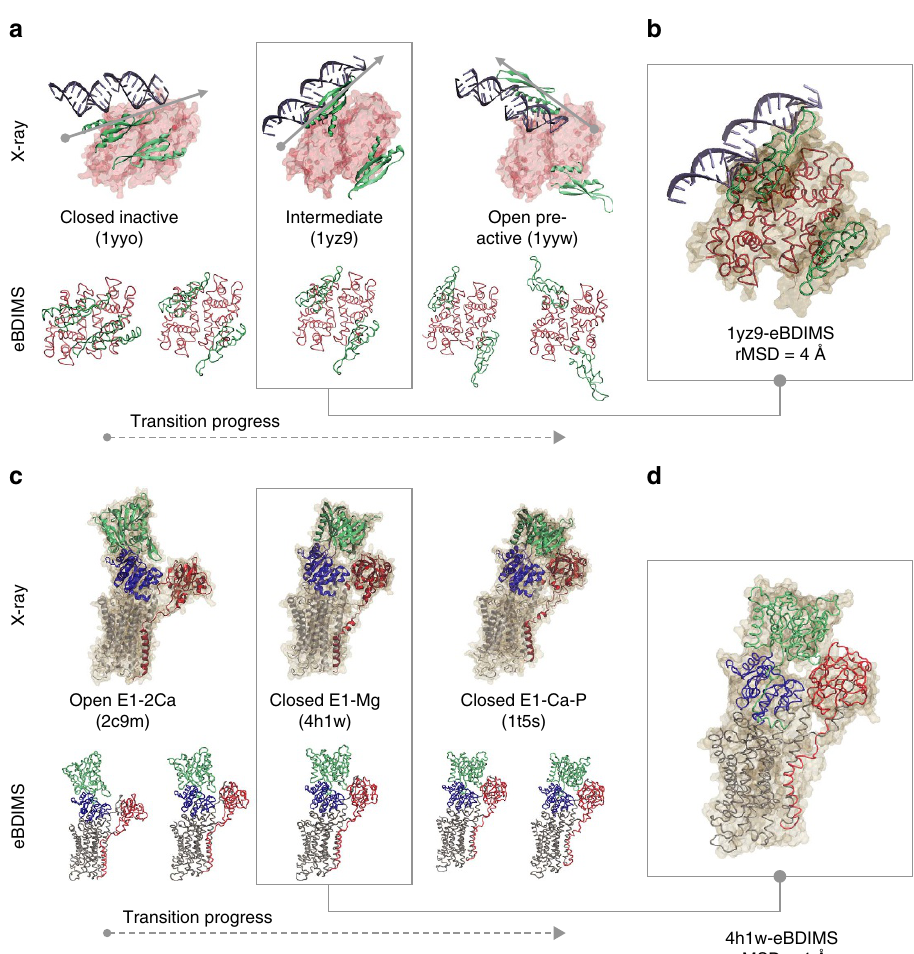
Figure 6 | Comparison between the crystallographic and the eBDIMS pathways for RNaseIII and SERCA. ( a ) Upper row: The complete X-ray structures for the RNaseIII end-states and the intermediate are shown bound to the dsRNA substrate; these conformations represent three sequential snapshots along the RNaseIII cycle. The starting structure is bound but catalytically inactive, and the following two show the progress to reorient the dsRNA onto the catalytic cleft (approximately in the z axis of symmetry). Lower row: as the two dsRNA-binding domains start to open the eBDIMS pathway shows how they spontaneously sample PC1 approaching the 1yz9 intermediate (shadowed); then, they leave it behind as rotation along PC2 progresses. ( b ) Superimposition between X-ray intermediate structure 1yz9 and the best overlapped eBDIMS frame. ( c ) Upper row: The complete X-ray structures for the SERCA open and closed end-states and one of the Mg 2 þ -bound visited intermediates (4h1w) are shown; the structure is approached within 4Å ( d ) by the forward eBDIMS pathway tracking headpiece